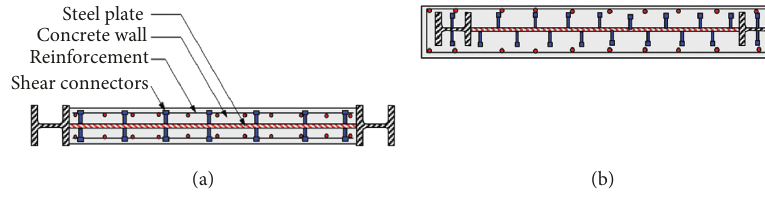
Figure 1: SPRC shear wall.